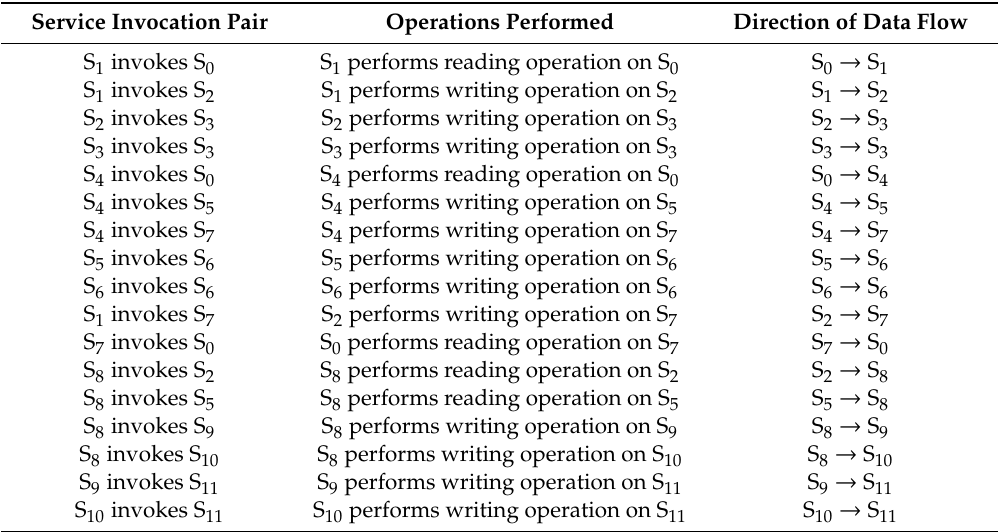
Table 7. Service invocation elements in client-side information reception module.